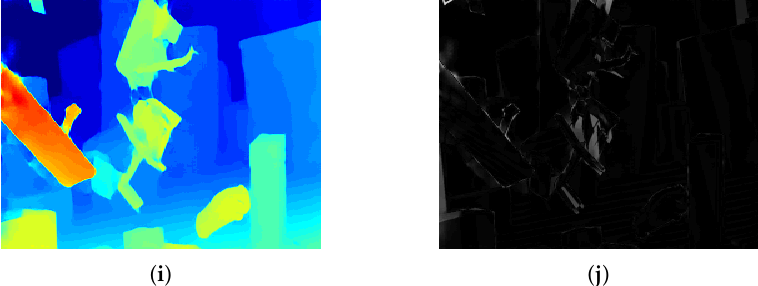
Figure 5. A qualitative result with inputs from PLSM [5] and Monodepth [7] in stereo-monocular fusion. The lighter pixels represent bigger disparity errors in figure ( d , f , h , j ). ( a ) Ground Truth; ( b ) Color image;